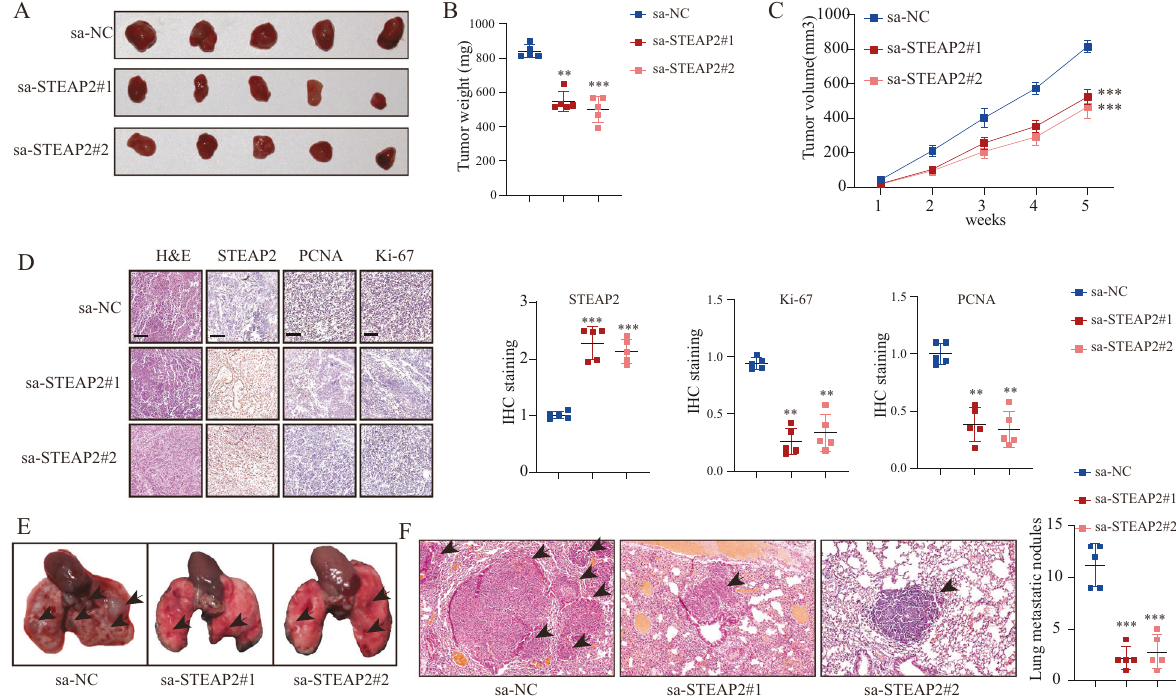
Fig. 4 STEAP2 inhibits xenograft growth and lung metastasis of PTC in vivo. For the in vivo tumor metastasis assay, BCPAP cells were injected subcutaneously into the fl anks of the mice following multipoint intratumor injection with STEAP2-saRNA or NC-saRNA ( A ). Afterward, tumor weight ( B ) in mice at 31 days after injection and growth curve of xenografts ( C ) were determined. D STEAP2, Ki-67, and PCNA expression were detected by IHC in xenografts sections. Scale bar: 100 μ m. For the in vivo tumor metastasis assay, BCPAP cells were injected into the tail vein of the mice following tail vein injection with STEAP2-saRNA or NC-saRNA. E Representative images of metastatic tumor nodules in the lung of nude mice. F Number of metastatic tumor nodules in the lung were compared between nude mice injected with STEAP2-saRNA and NC-saRNA and statistically analyzed. Scale bar: 150 μ m. All data are presented as the mean ± standard deviation. * P < 0.05, ** P < 0.01, and *** P <